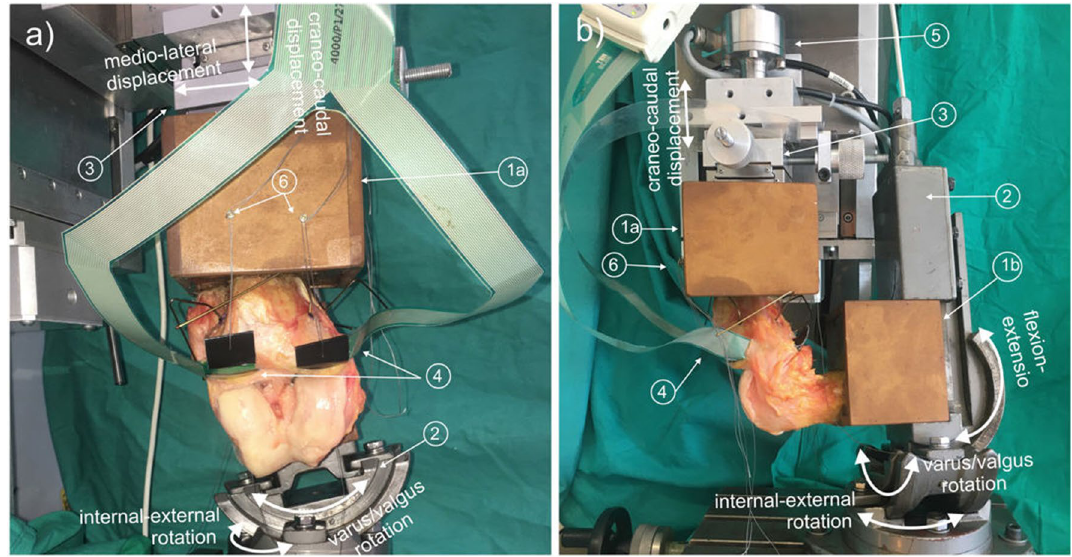
Figure 1. Experimental setup: ( a ) frontal and ( b ) lateral view showing the testing machine with a right knee specimen mounted at 90° flexion. White arrows highlight the machine elements that enable the movements associated with the degrees of freedom of the experiment. ( a ) Tibial container; ( b ) femoral container; 2: clamp that permits three-dimensional rotation used to fix the femur; 3: actuator of the machine with linear ball